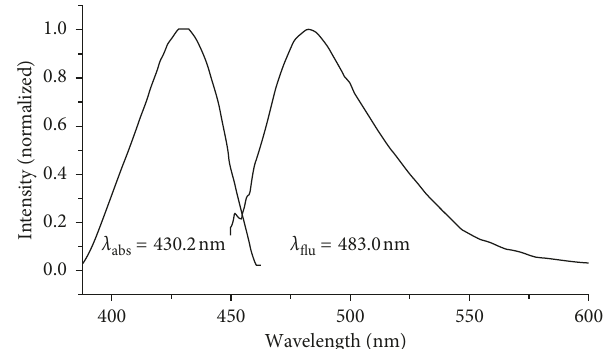
Figure 2: Absorption (left) and fluorescence (at 430nm excitation, right) spectra of BMN in acetonitrile.